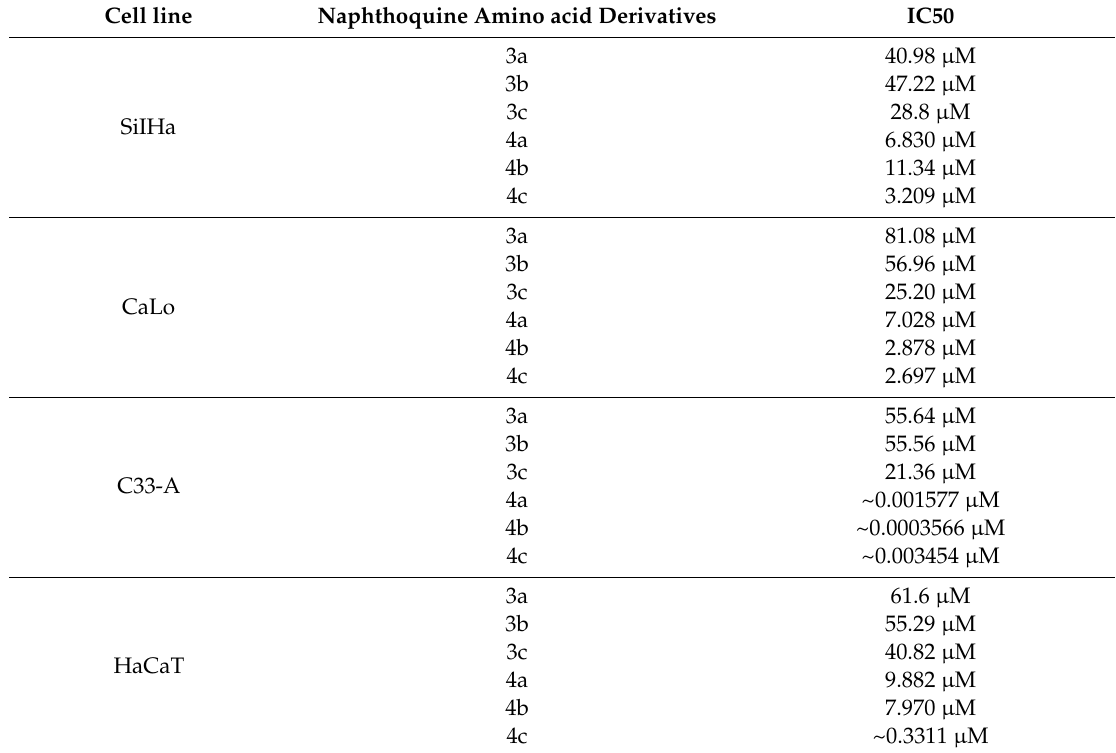
Table 3. IC50 of naphthoquinone amino acid derivatives in immortal and tumorigenic cell lines after 72 h exposure. Results obtained from three independent